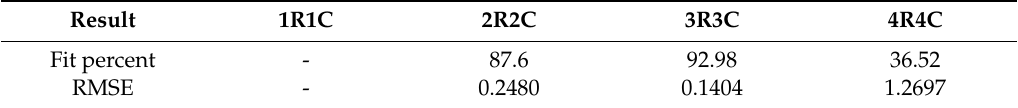
Table 8. Thirty-minute prediction results for experiment B.